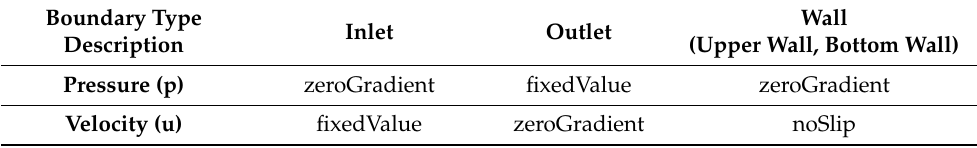
Table 3. Boundary conditions of the backward-facing step in the laminar regime.